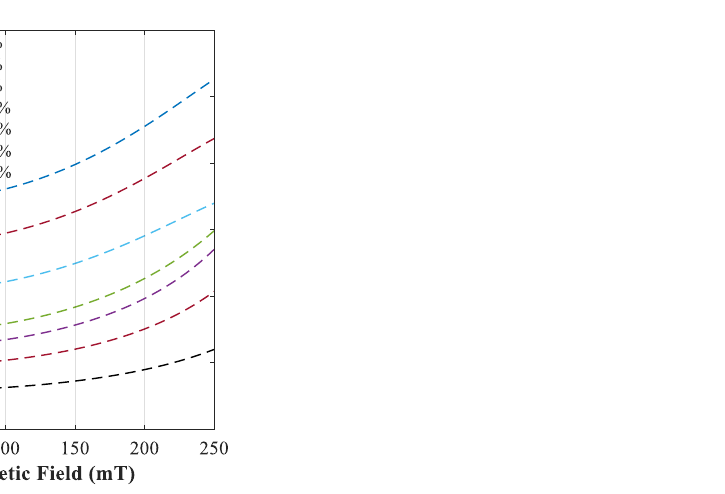
Figure 10. Dependence of material properties (Young’s Modulus) to the magnetic field for various iron volume fractions. Table 2. Branch numbers related to various bandgaps in band diagrams of the modified unit cell with a cylindrical core of L / R = 5 and the arm angle of θ =